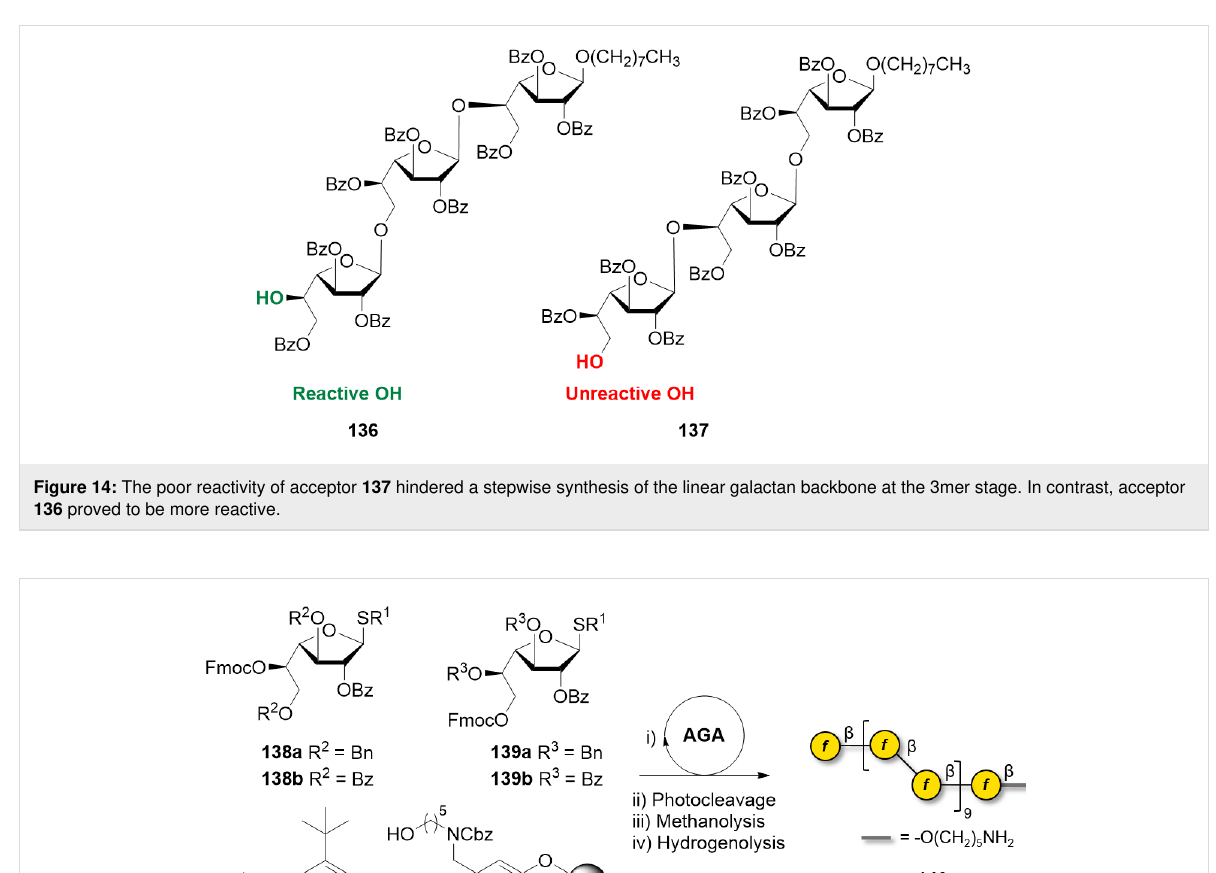
proaches to access Gal in the furanose form involved dithio- acetal cyclization using iodine and an alcohol [358] or a recently reported pyranoside-into-furanoside (PIF) rearrange- ment [360]. Frequent O-5 → O-6 ester migration is observed in basic media. The migration could be reduced by using